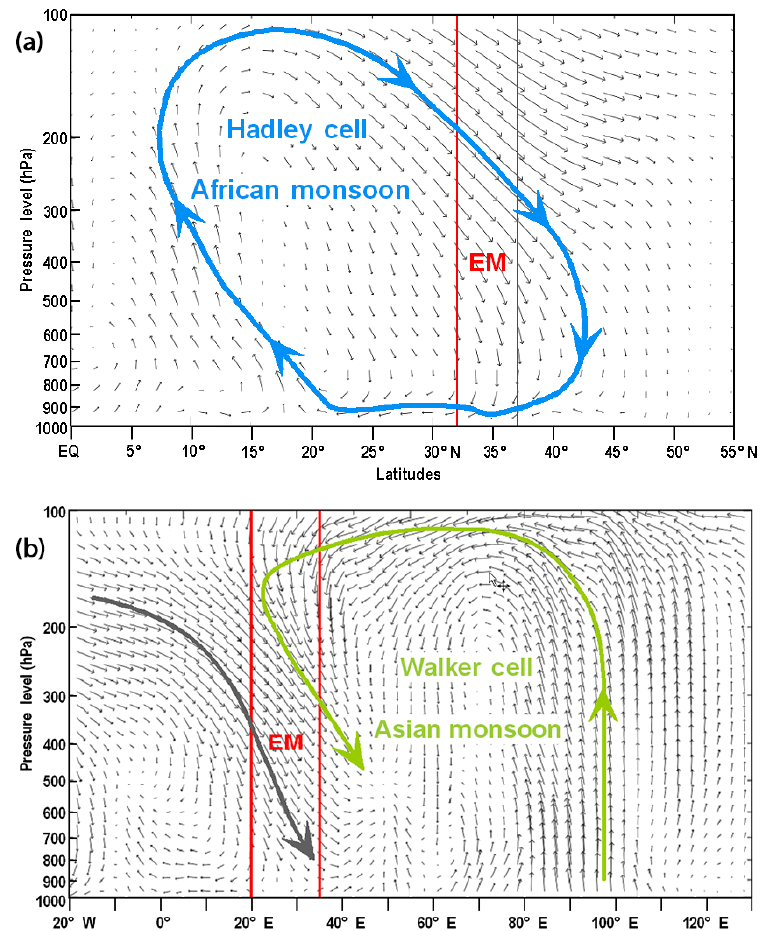
Figure 3. (a) Closed Hadley cell circulation of the African monsoon depicted by the vertical cross section of wind vectors for July–August, averaged over the 30–40 ◦ E longitudinal band. (b) Closed Walker cell circulation of the Asian monsoon depicted by the vertical cross section of wind vectors for July–August, averaged over the 20–35 ◦ N latitudinal band. The two figures are based on the NCEP/NCAR long-term averages (1948–2016) with the position of the eastern Mediterranean (EM) in red. NCEP reanalysis data are provided by the NOAA/OAR/ESRL PSD, Boulder, Colorado, USA;